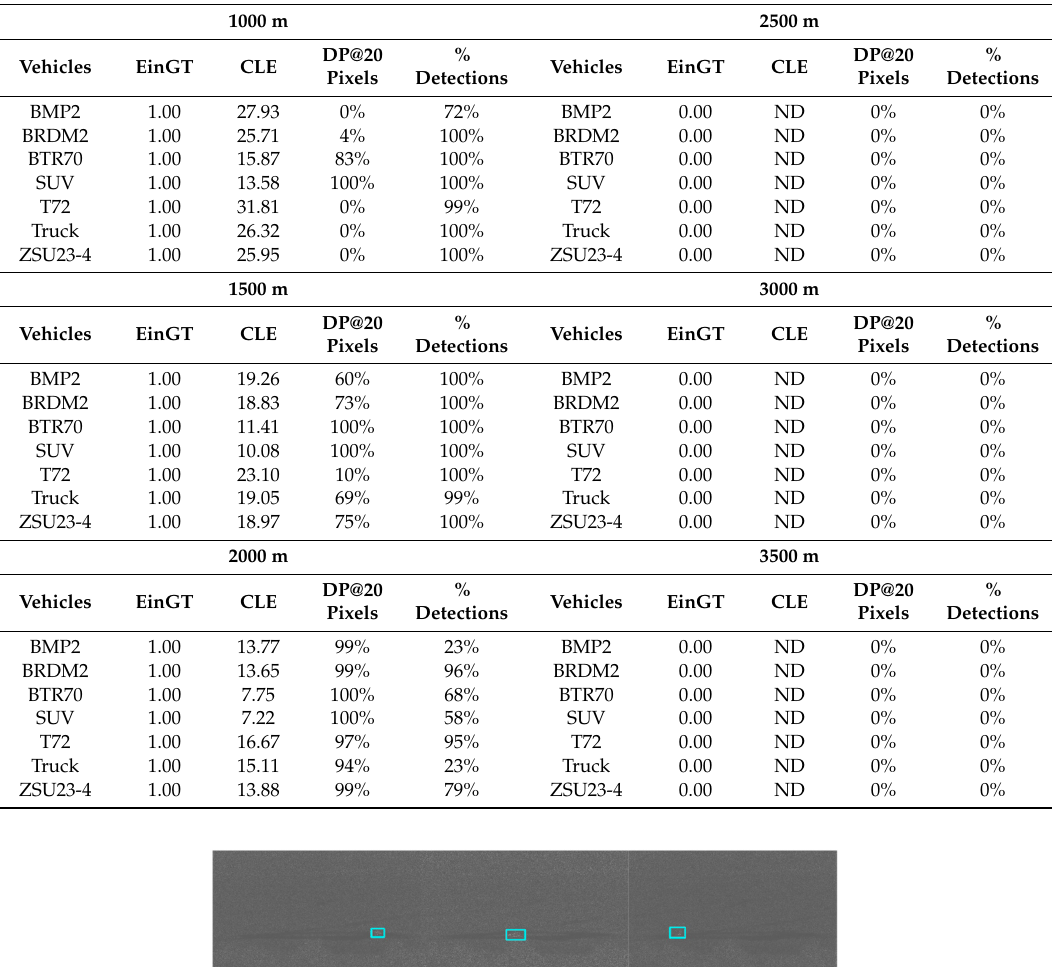
Table A10. Tracking metrics for PCE 25 (MWIR nighttime). ND means no detection. 1000 m 2500 m